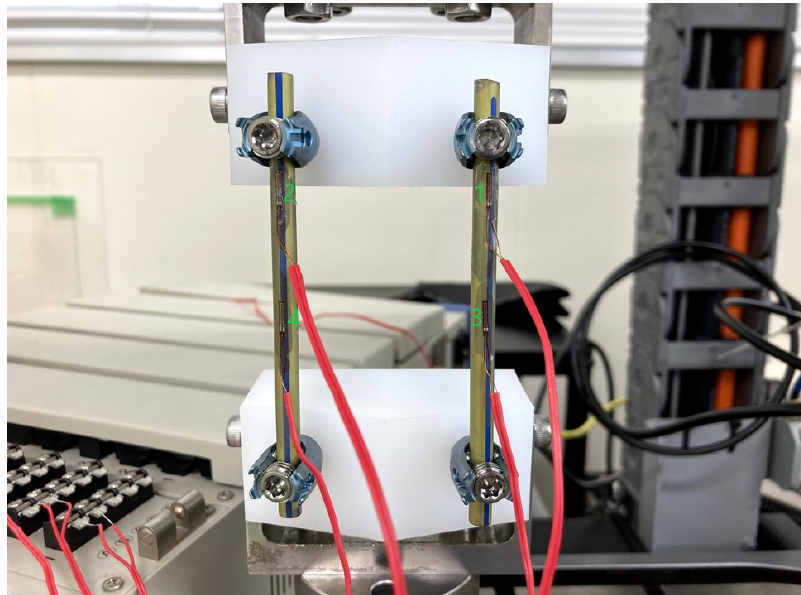
Figure 3. Four strain gauges were installed on the rod to measure the strain in the rod. The numbers are shown for channel identification.